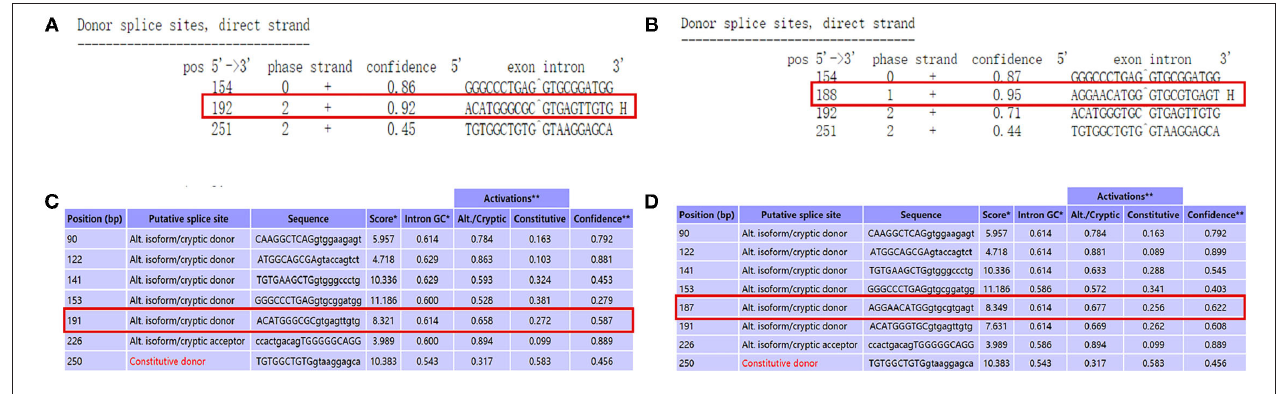
FIGURE 4 | Use prediction software to analyze the variant site. (A) The predict result of wild type by using NetGene2 Server (the red square represented). (B) “AGGAACATGG GTGCGTGAGT” was the appropriate predict result to affects the splicing impact by using NetGene2 Server (the red square represented). (C) The predict result of wild type by using ASSP (the red square represented). (D) The predict result of mutant type by using ASSP (the red square represented).